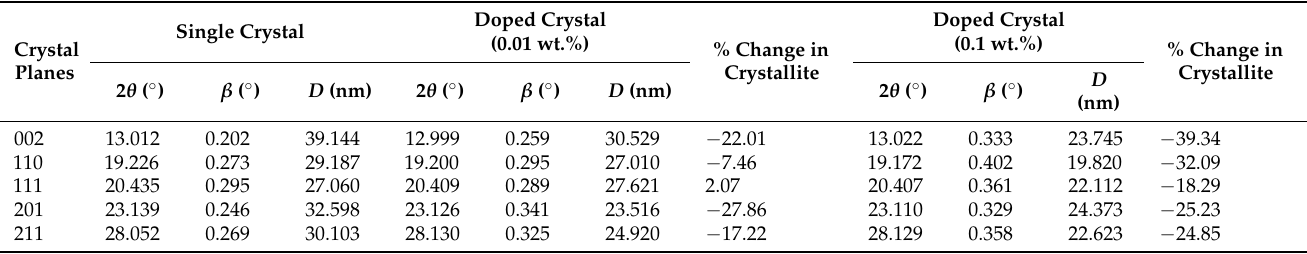
Table 2. Change in crystallite size corresponding to different planes of pentacene-doped p-terphenyl crystals.